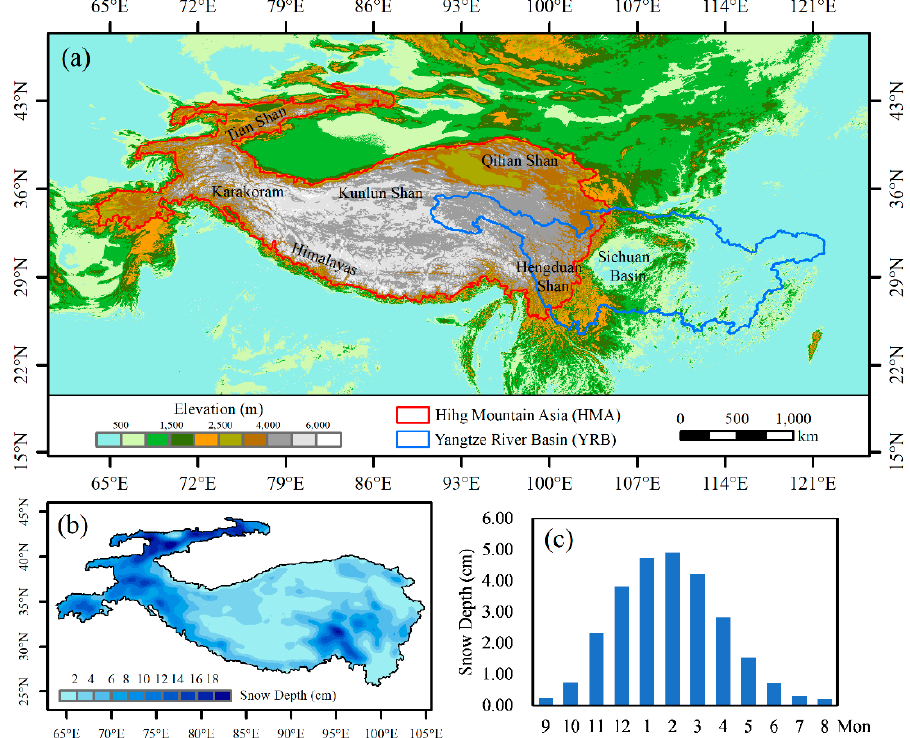
Figure 1. ( a ) Topography of High Mountain Asia (HMA) and the Yangtze River Basin (YRB), ( b ) distribution of winter snow depth in HMA from 1980 to 2019, and ( c ) monthly distribution of HMA snow depth from 1980 to 2019.